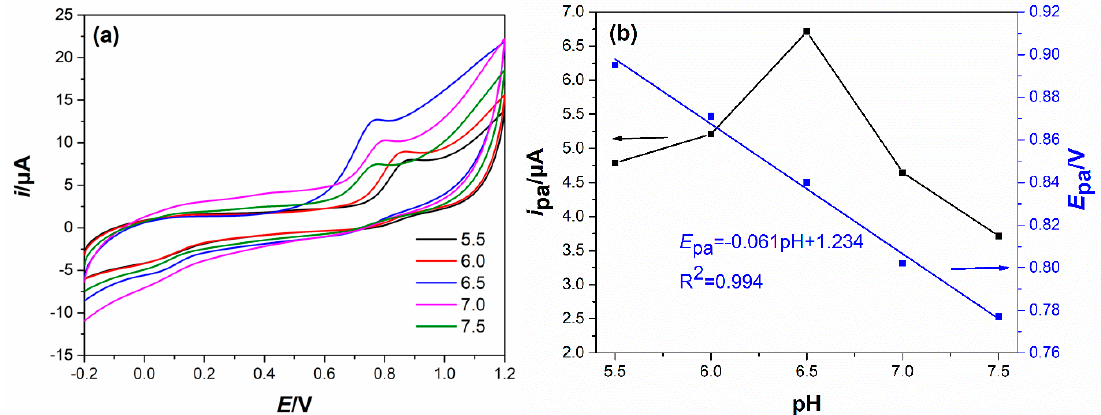
Figure 5. Effect of solution pH on the electrochemical responses of 10 μ M Trp. ( a ) CV curves in different pH PBS. ( b ) Effect of solution pH on the anodic peak currents (black line) and the anodic peak potentials (blue line). Supporting electrolyte: 0.1M PBS; Scanning rate: 0.1 V/s; Accumulation potential: 0.2 V; Accumulation time: 210 s.